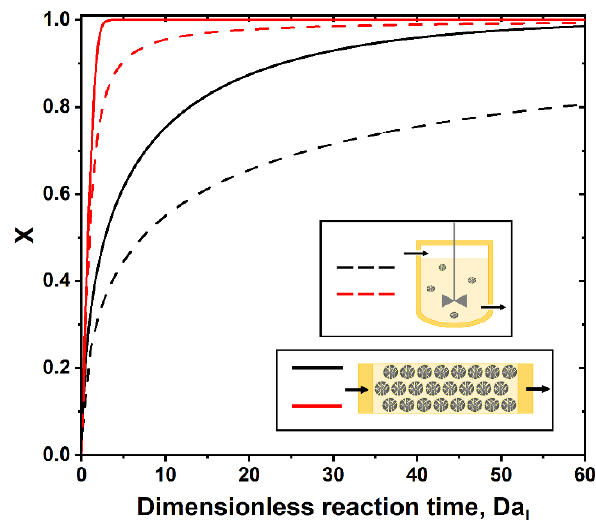
Figure 5. Analysis of conversion of cellobiose dependent on enzyme kinetic, continuous reactor type and residence time. Conversion vs. dimensionless reaction time or first Damköhler number for first order reaction for the CSTR reactor (dashed line) and plug flow/batch reactor (solid line) employing a kinetic model of Michaelis-Menten (red lines) and inhibition acompetitive substrate inhibition and double competitive product inhibition model (black lines). These results were simulated using the kinetics constants obtained for the free enzyme (Table S3, Supplementary Materials) and V max measured for the Ag-Gly 2000 U _pNPG /g support